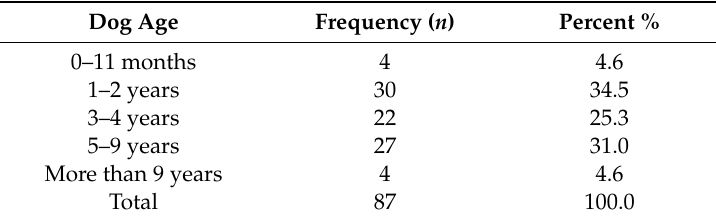
Table 7. Ages of dogs aggressive towards humans.